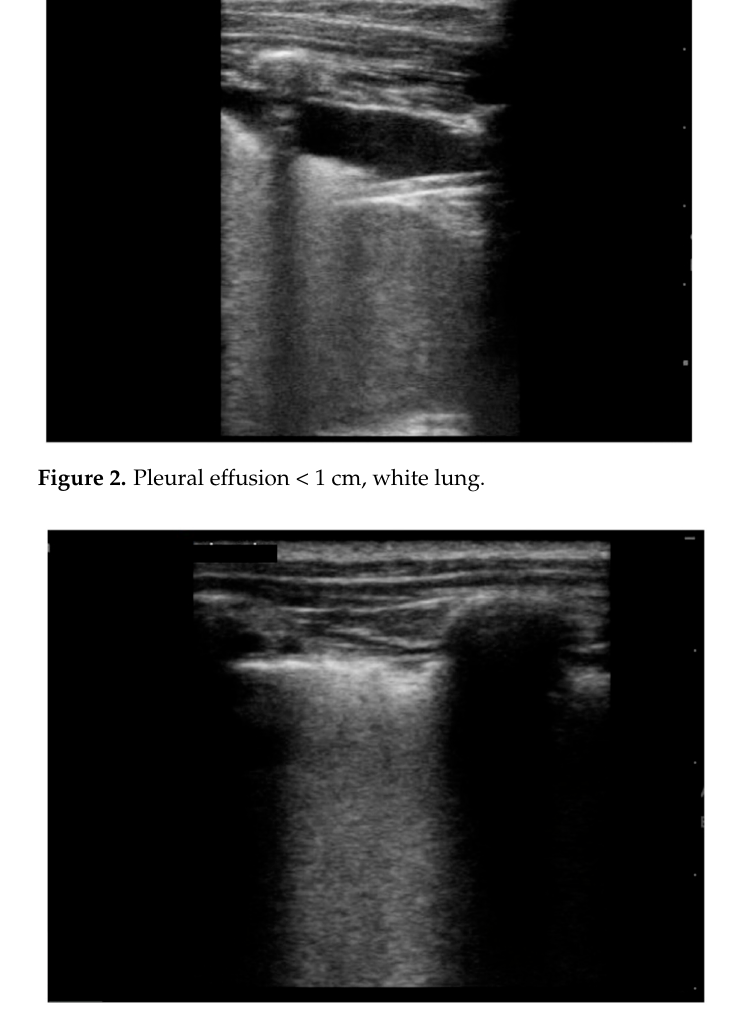
Figure 3. Subpleural consolidation < 1 cm, white